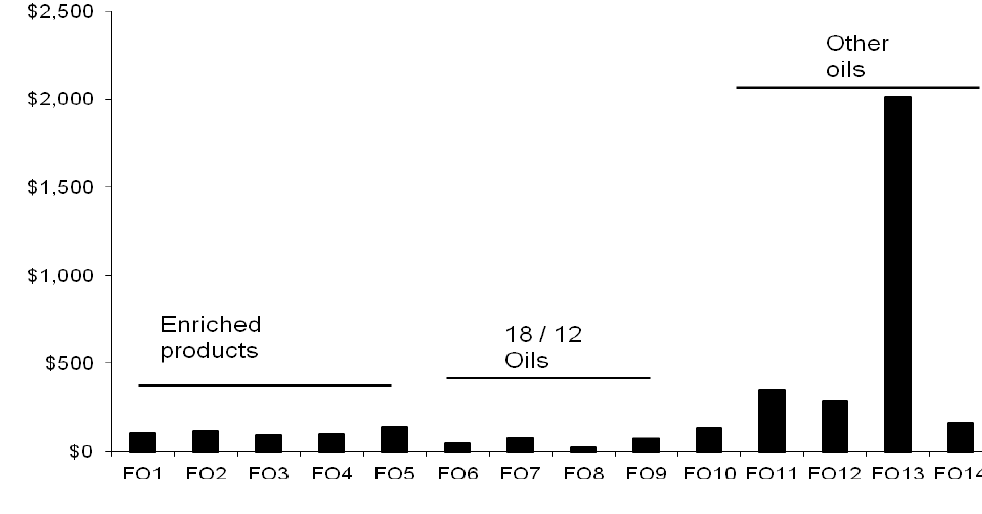
Figure 4. Cost per annum of fish oil products to supply 500 mg/day EPA + DHA.